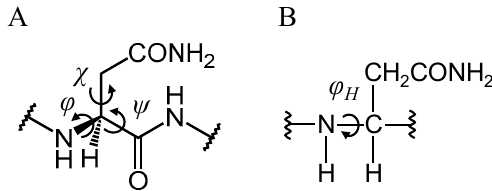
Figure 4. Dihedral angles used in this study to analyze the main-chain conformationof Asn residues (A for φ , ψ , and χ , B for φ H ).